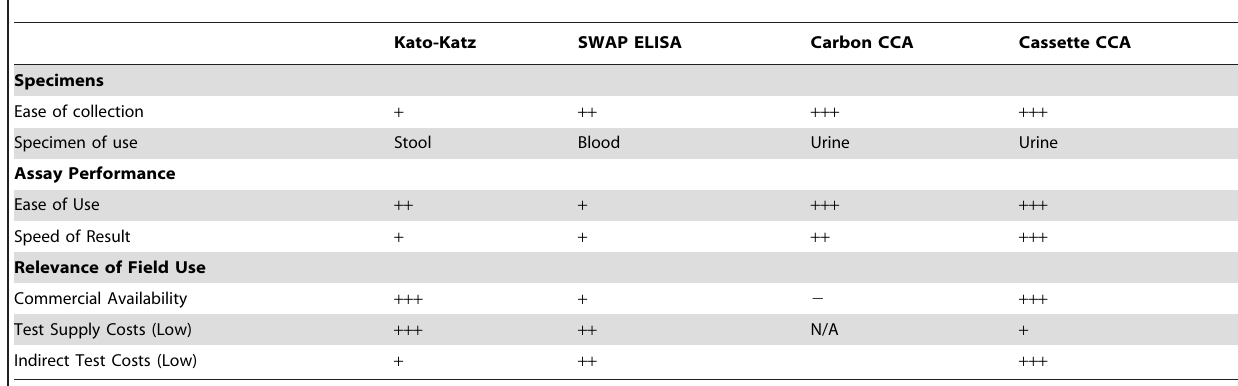
Table 4. Comparison of characteristics important for effective screening